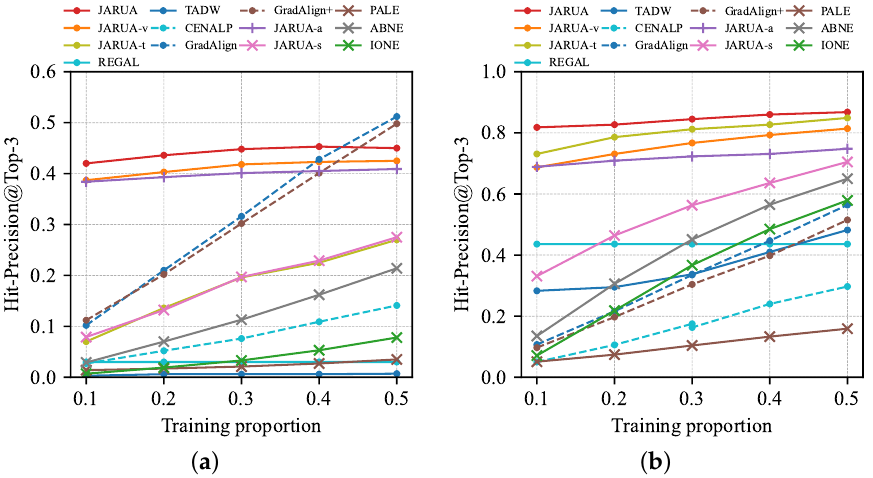
Figure 4. Hit-Precision performances with respect to the training proportion on ( a ) social networks, ( b ) coauthor networks.